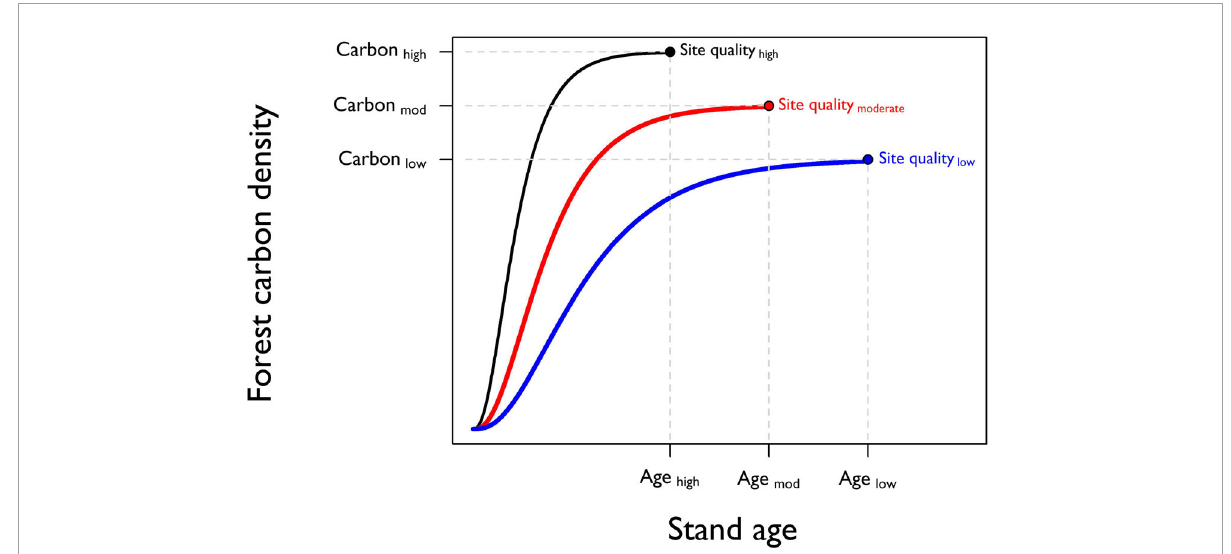
FIGURE2 Prediction of how site quality affects forest carbon accumulation over time. At the stand level, site quality gradients influence the rate of forest carbon accumulation and constrain maximum forest carbon density. Stands with higher site quality are predicted to reach the age at the onset of old growth (Age high ) more rapidly than lower quality sites (Age low ). High-quality sites are also predicted to support a greater density of forest carbon at the age of the onset of old growth (Carbon high ) compared to lower quality sites (Carbon low